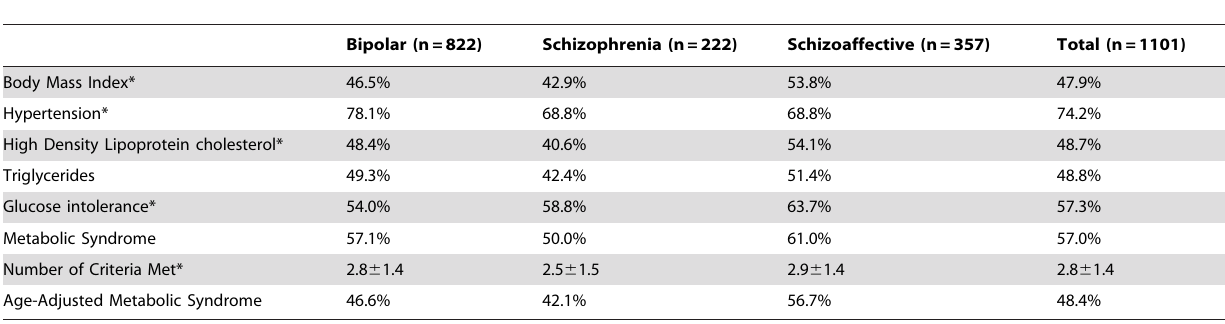
Table 4. Metabolic Syndrome Components for Completely Monitored